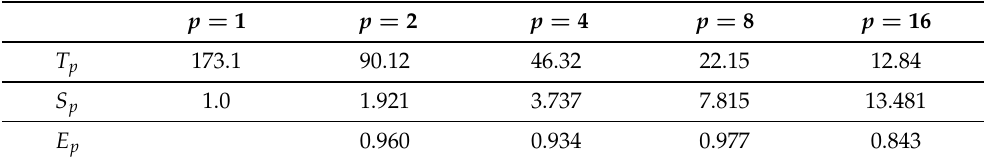
Table 8. The spectral symmetrical splitting algorithm: the values of the speedup S p and efficiency E p numbers for α = 0.85 and different numbers of